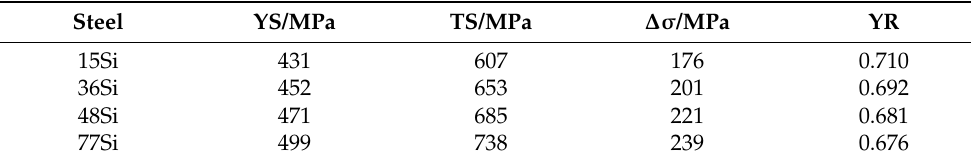
Figure 3. Typical engineering stress-strain curves of each Si-containing sample. Table 2. Summary of the tensile results.